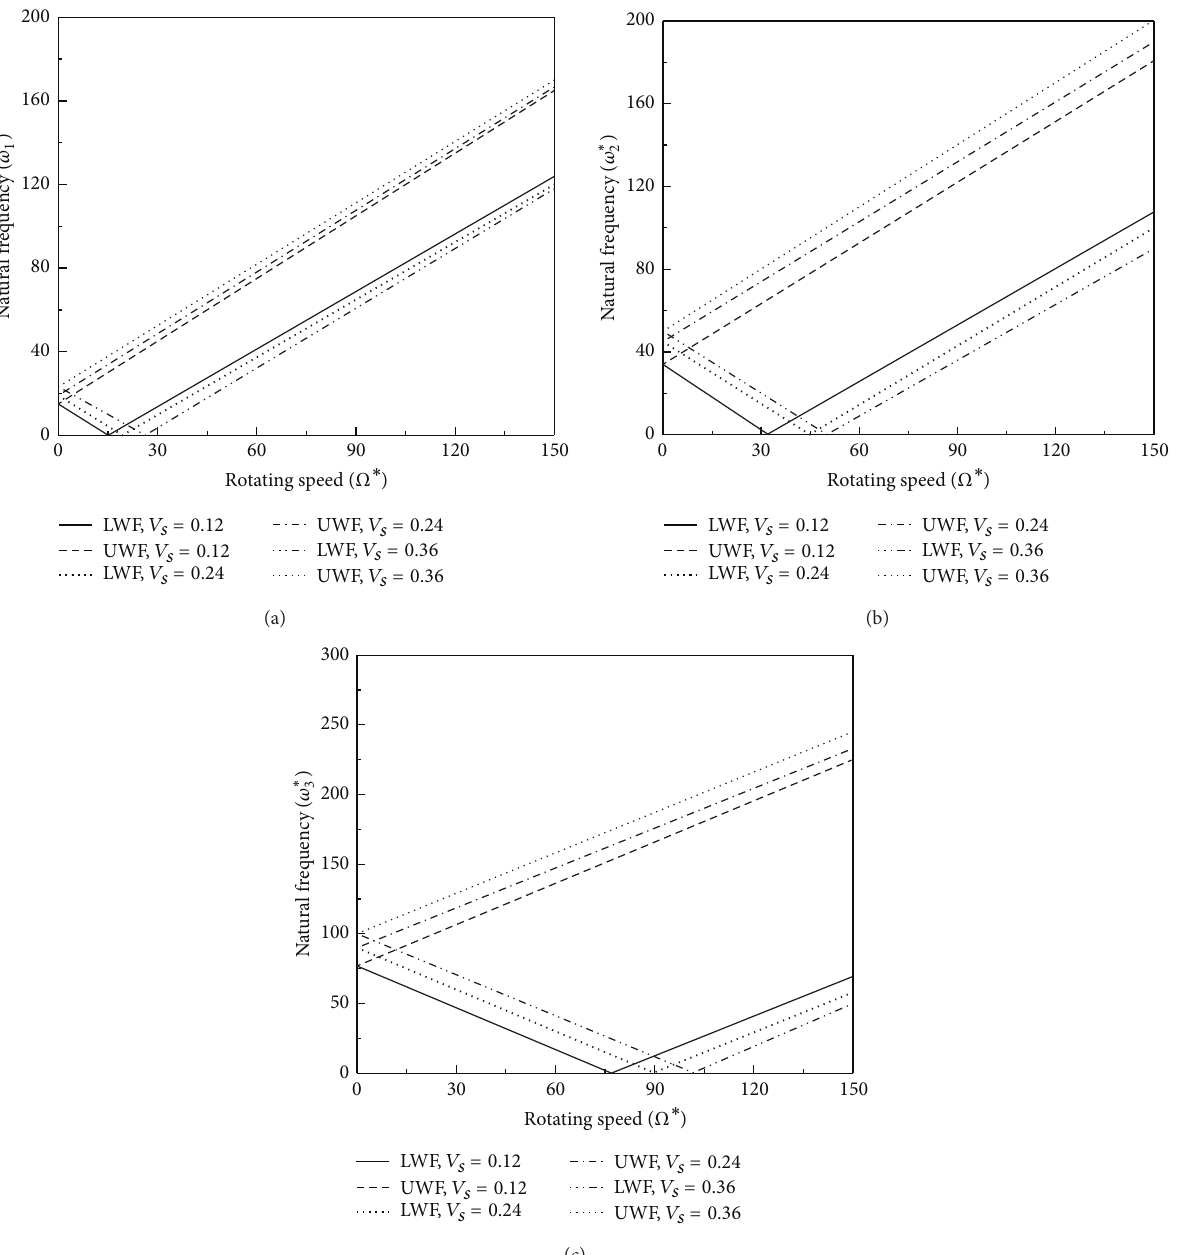
Figure 3: The first three natural frequencies versus rotating speed for different SMA wire fractions ( 𝜃 = 30 ∘ ; 𝑇 = 50 ∘ C; 𝜀 0 = 0.067